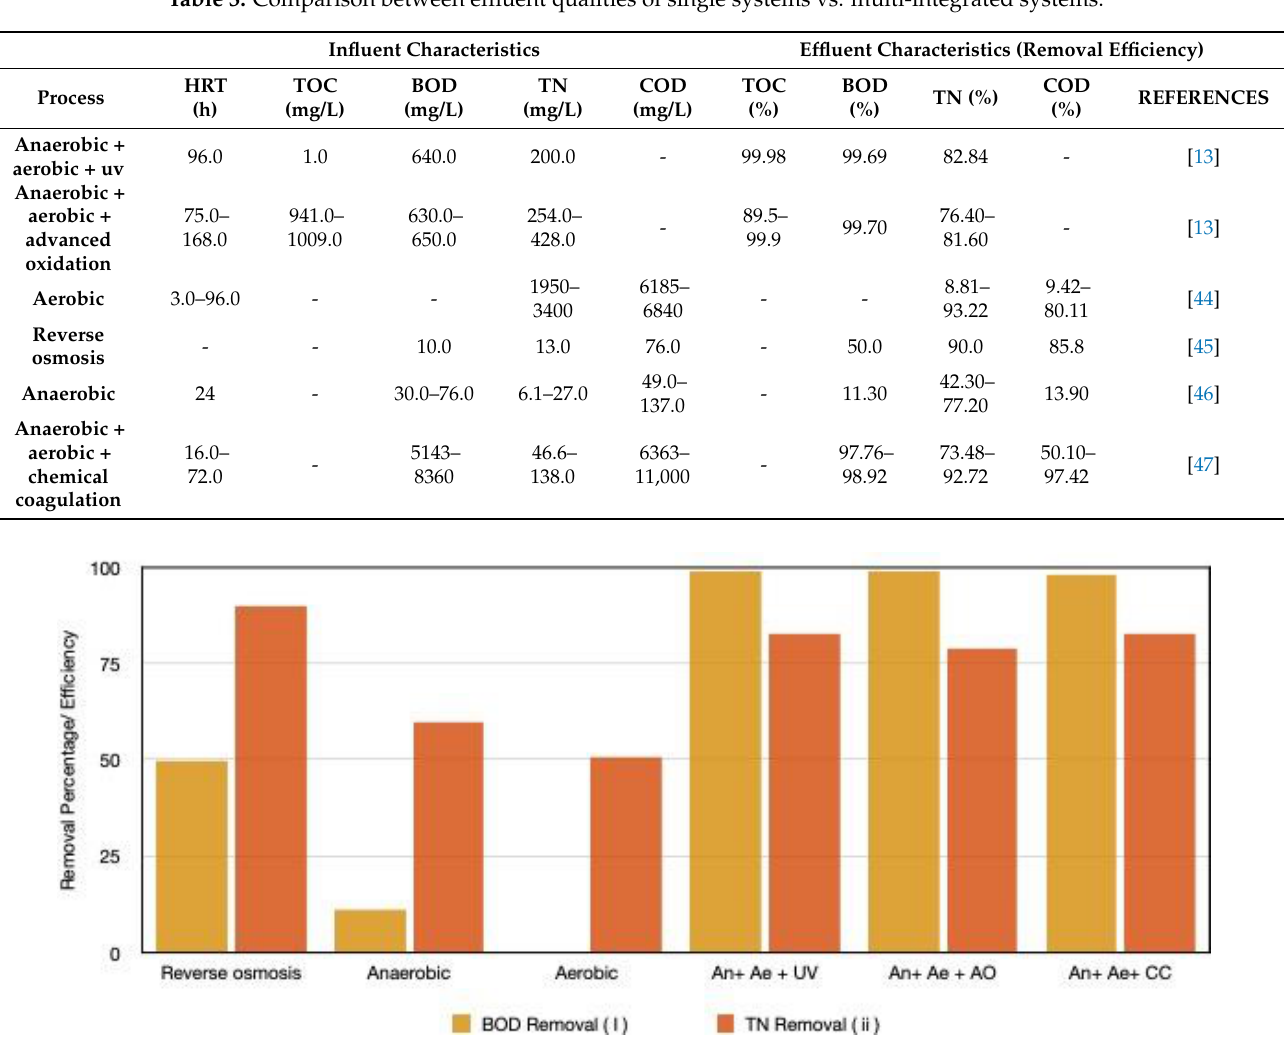
Figure 5. Comparison between single systems and MIS in removing BOD & TN [Abbreviations: An — anaerobic process; Ae — aerobic process; AO — advanced oxidation process, CC — chemical coagulation]. Table 3. Comparison between effluent qualities of single systems vs. multi-integrated systems .